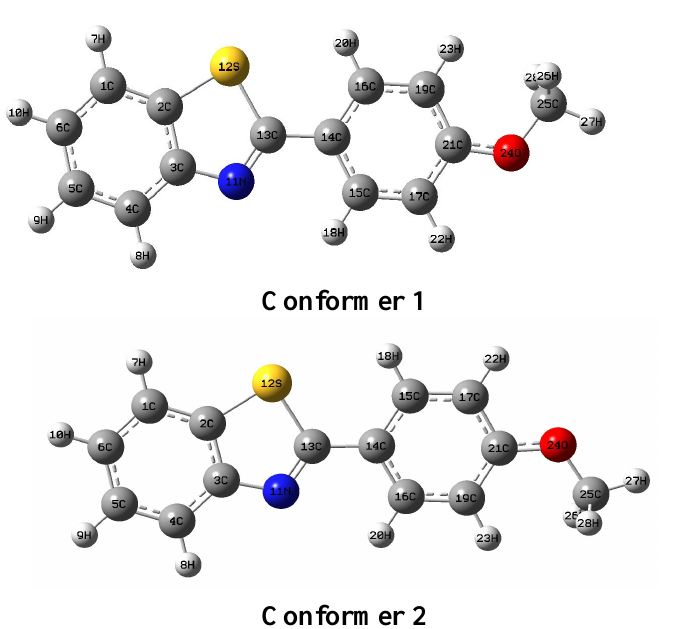
Figure 1. Two stable conformers of the title compound calculated at HF/6-311G(d,p) level.